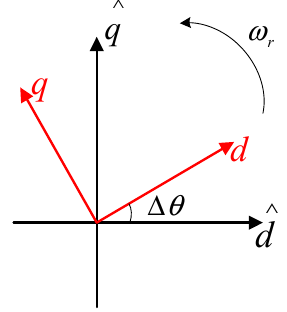
Figure 1. Relationship of the two reference frames.